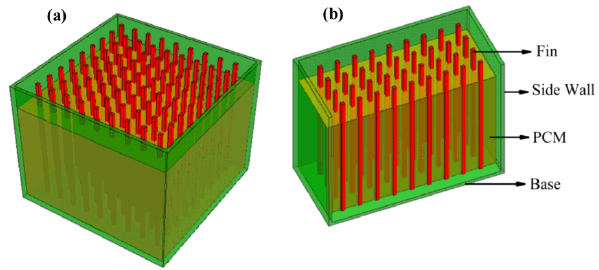
Figure 1. Example of a PCM-based pin fin heat sink: (a) actual geometry and (b) sectioned view. Table 1. Numerical cases explored in this